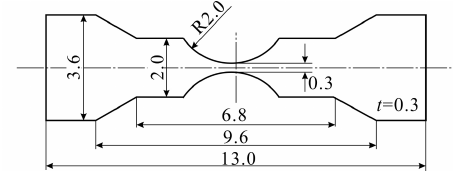
Figure 2. Shape and dimensions of